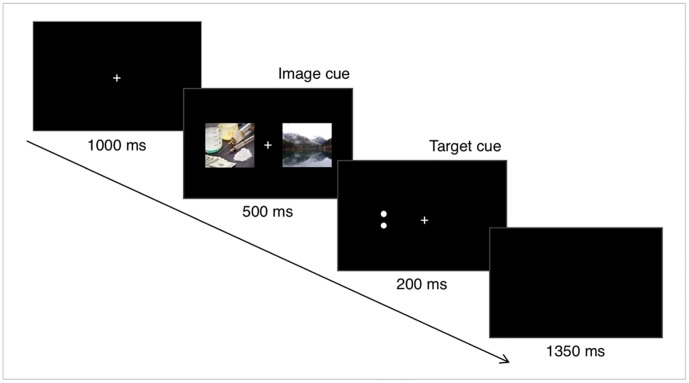
Experimental paradigm. Each trial began with a fixation cross with 1000 ms duration. Immediately following offset of the fixation cross, a drug-related image and a neutral image were presented bilaterally for 500 ms. Next, a target stimulus, which was either a horizontal or a vertical pair of dots, was shown for 200 ms. The trial ended with a 1350 ms intertrial interval.